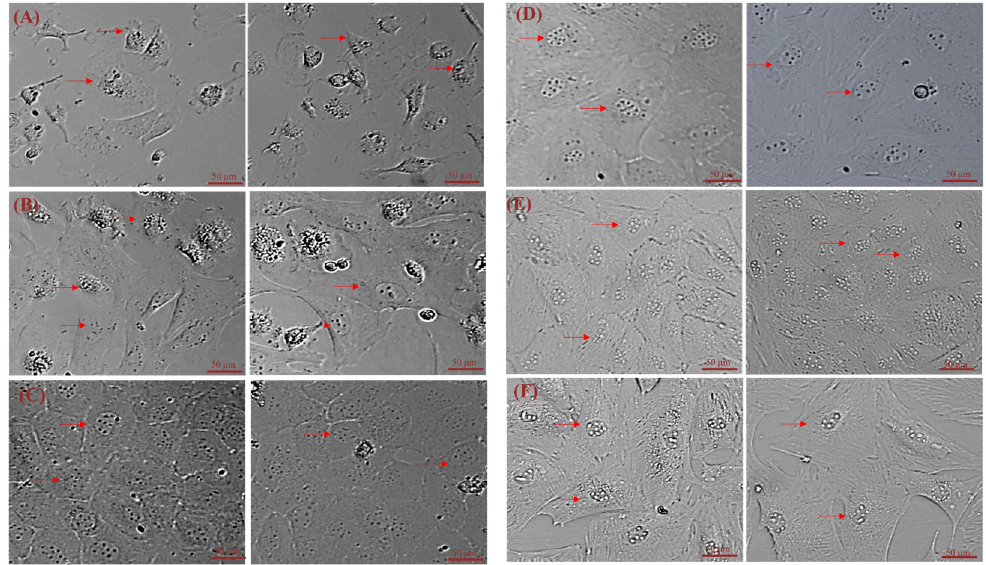
Figure 5. Steps of subculturing of primary sheep hepatocytes (brightfield imaging). ( A ) Passage 1; ( B ) Passage 2; ( C ) Passage 4; ( D ) Passage 7; ( E ) Passage 10; ( F ) Passage 5 after resuscitation. Note: red arrows indicate primary hepatocytes.